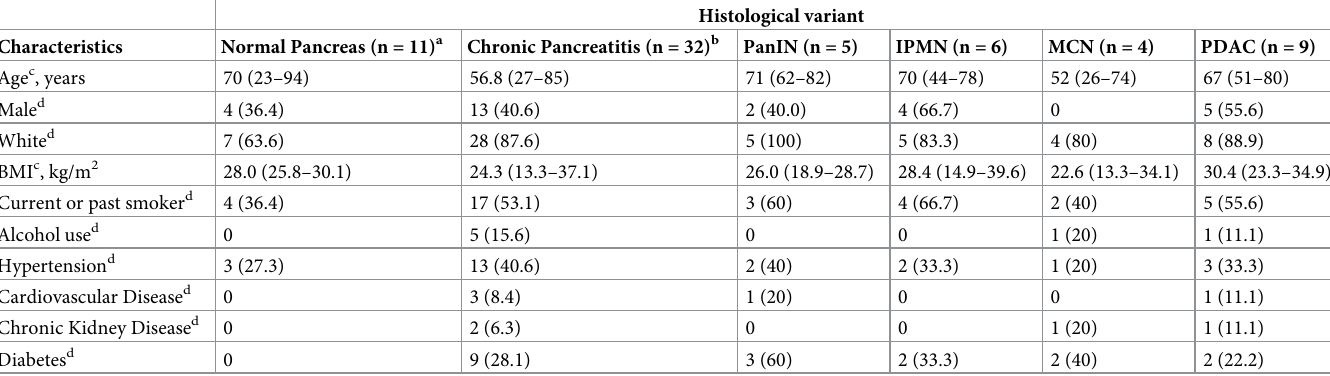
Table 1. Sociodemographic characteristics for RNLS immunohistochemistry patients.